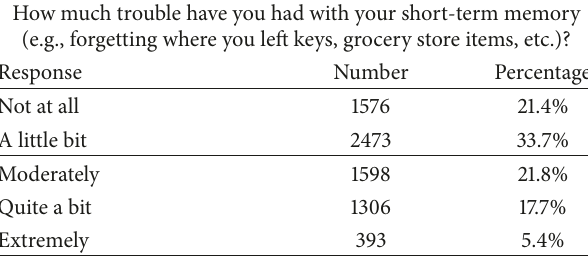
Table 4: Frequency table of responses to SAMHQ item on short- term memory